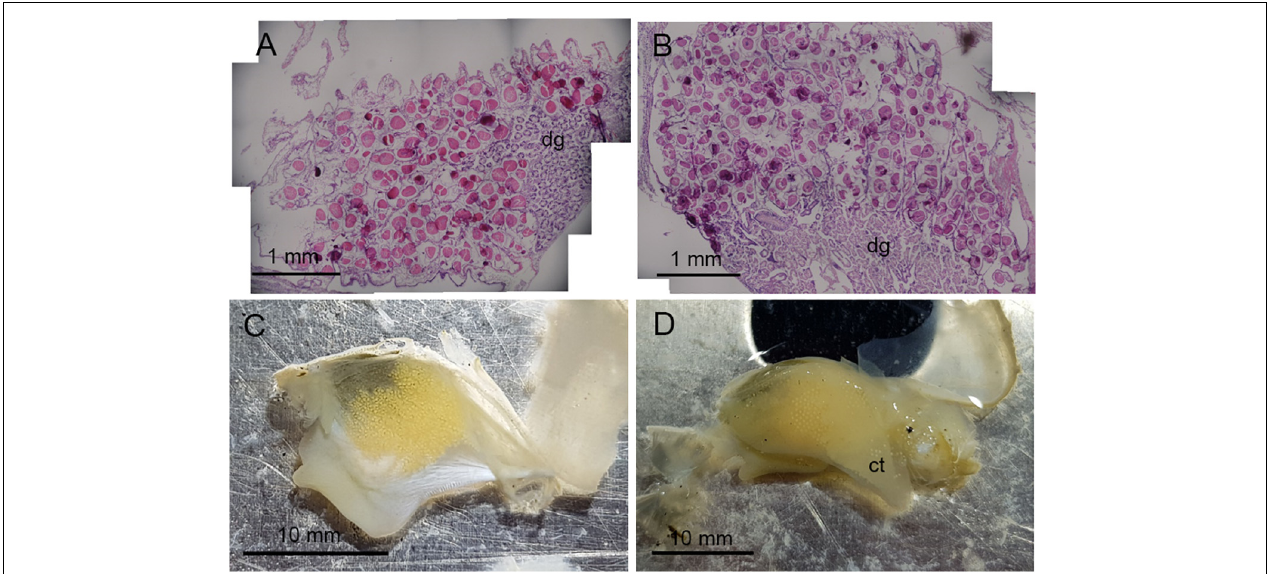
FIGURE 1 | Oocyte development in Astarte crenata from the Barents Sea. Transverse histology sections show oocyte development (A) surrounding the digestive diverticula under ambient environmental conditions and (B) in the gonadal alveoli under representative future environmental conditions. Microphotographs show (C) the arrangement of oocytes when within the gonad and (D) oocytes loosely held within the supra-branchial chamber on the ctenidia found in the future environmental conditions. dg, digestive diverticula; ct, ctenidia.